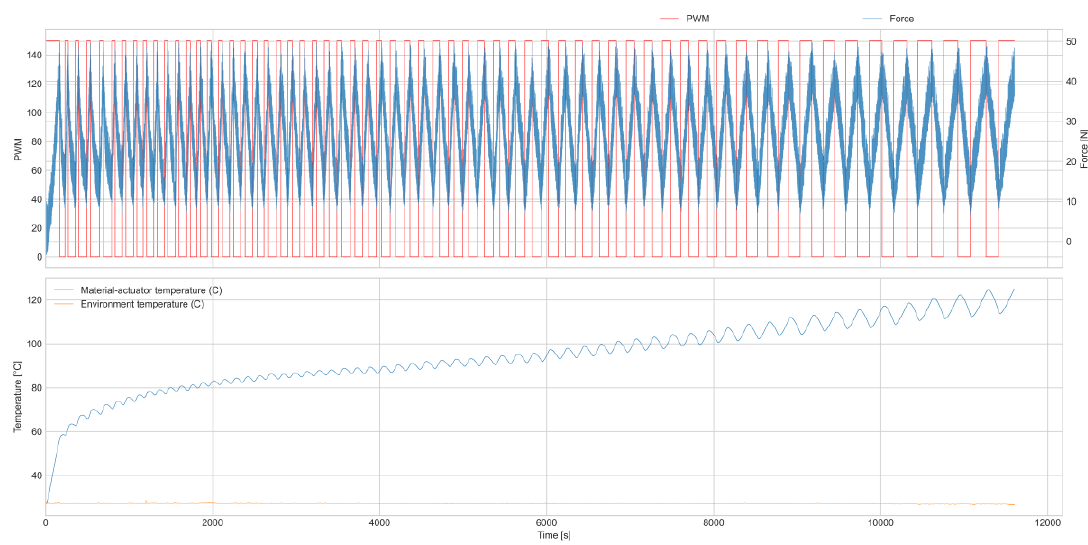
Figure A3. Complete temperature and force response plot of an 8 wt.% thermal filler infused material-actuator sample.